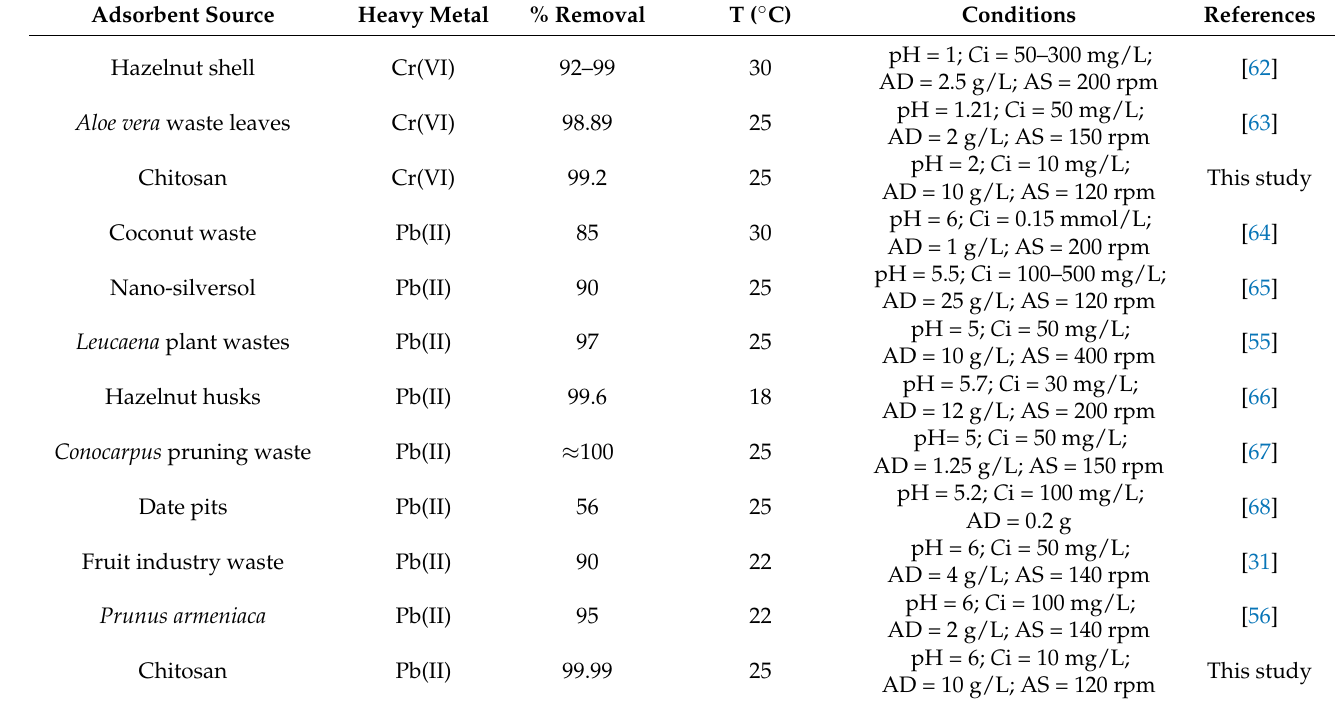
(C); Figure S2: FTIR spectra of pure Ch; Figure S3: FTIR spectra of Ch-based AC before and after removal of heavy metals; Figure S4: TGA-DTA curves of Ch; Figure S5: The effect of AC dose on the removal efficiency of Cr(VI) (A) and Pb(II) (B) ions; Figure S6: The effect of initial heavy metal ions concentration ( C i) on the removal efficiency of Cr(VI) (A) and Pb(II) (B) ions; Figure S7: The effect of contact time on the removal efficiency of Cr(VI) (A) and Pb(II) (B) ions; Figure S8: Effect of time on the Cr(VI) (A) and Pb(II) (B) ions removal from aqueous solution, to determining the q e as indicated on the plots; Figure S9: The adsorption isotherms for Cr(VI) and Pb(II) using modified 10Ch600.60K 2 CO 3 .U as adsorbent, Table S1: The calculation parameters of adsorption equilibrium isotherm models and kinetic models. The definition of the model parameters and their units are explained in the List of Symbols and Units in the main manuscript. The tested adsorbent is 10Ch600.60K 2 CO 3 .U, Figure S10. The adsorption isotherms for Cr(VI) (A) and Pb(II) (B) at different temperature using modified 10Ch600.60K 2 CO 3 .U as adsorbent. The definition of the model parameters and their units are explained in the List of Symbols and Units in the main